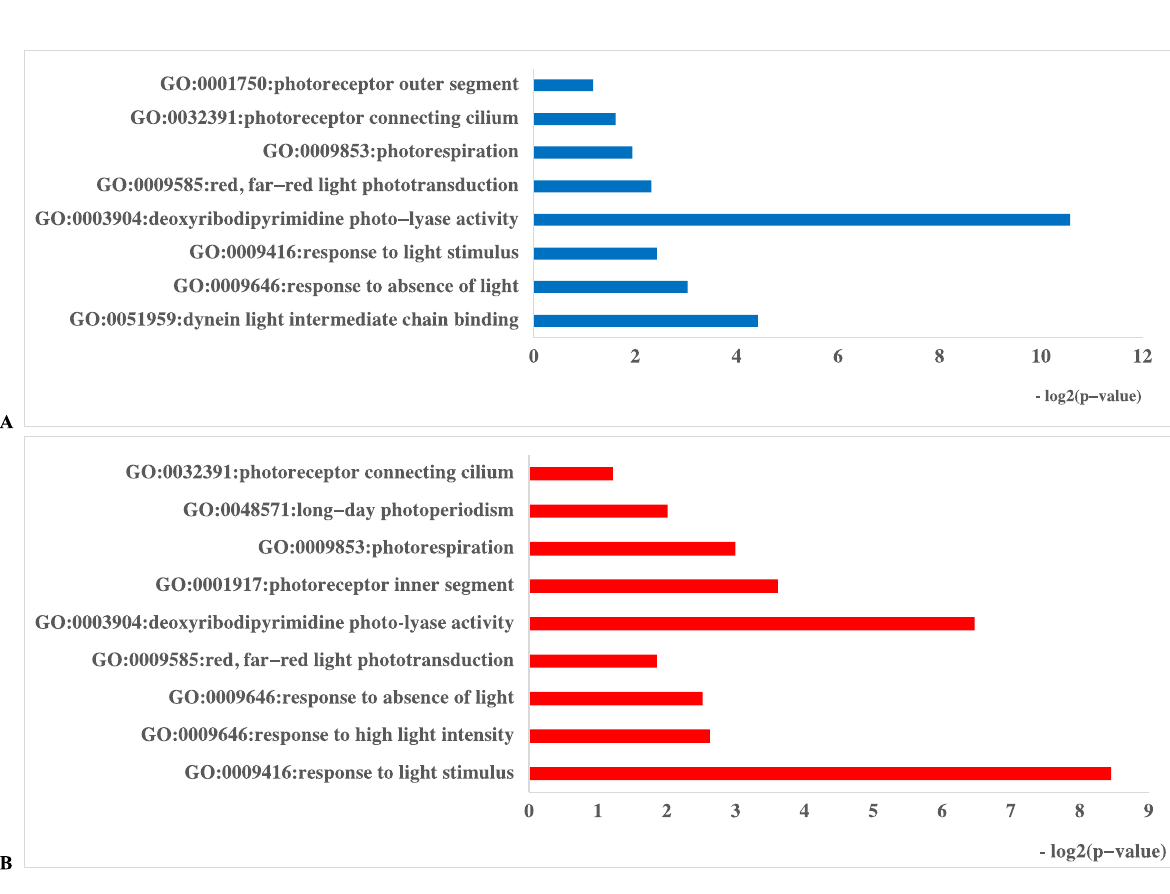
Figure 5. Gene Ontology (GO) database enrichment analysis of DEGs in primordium between blue or red-light conditions and darkness. ( A ). DEGs between D and B. ( B ). DEGs between D and R.